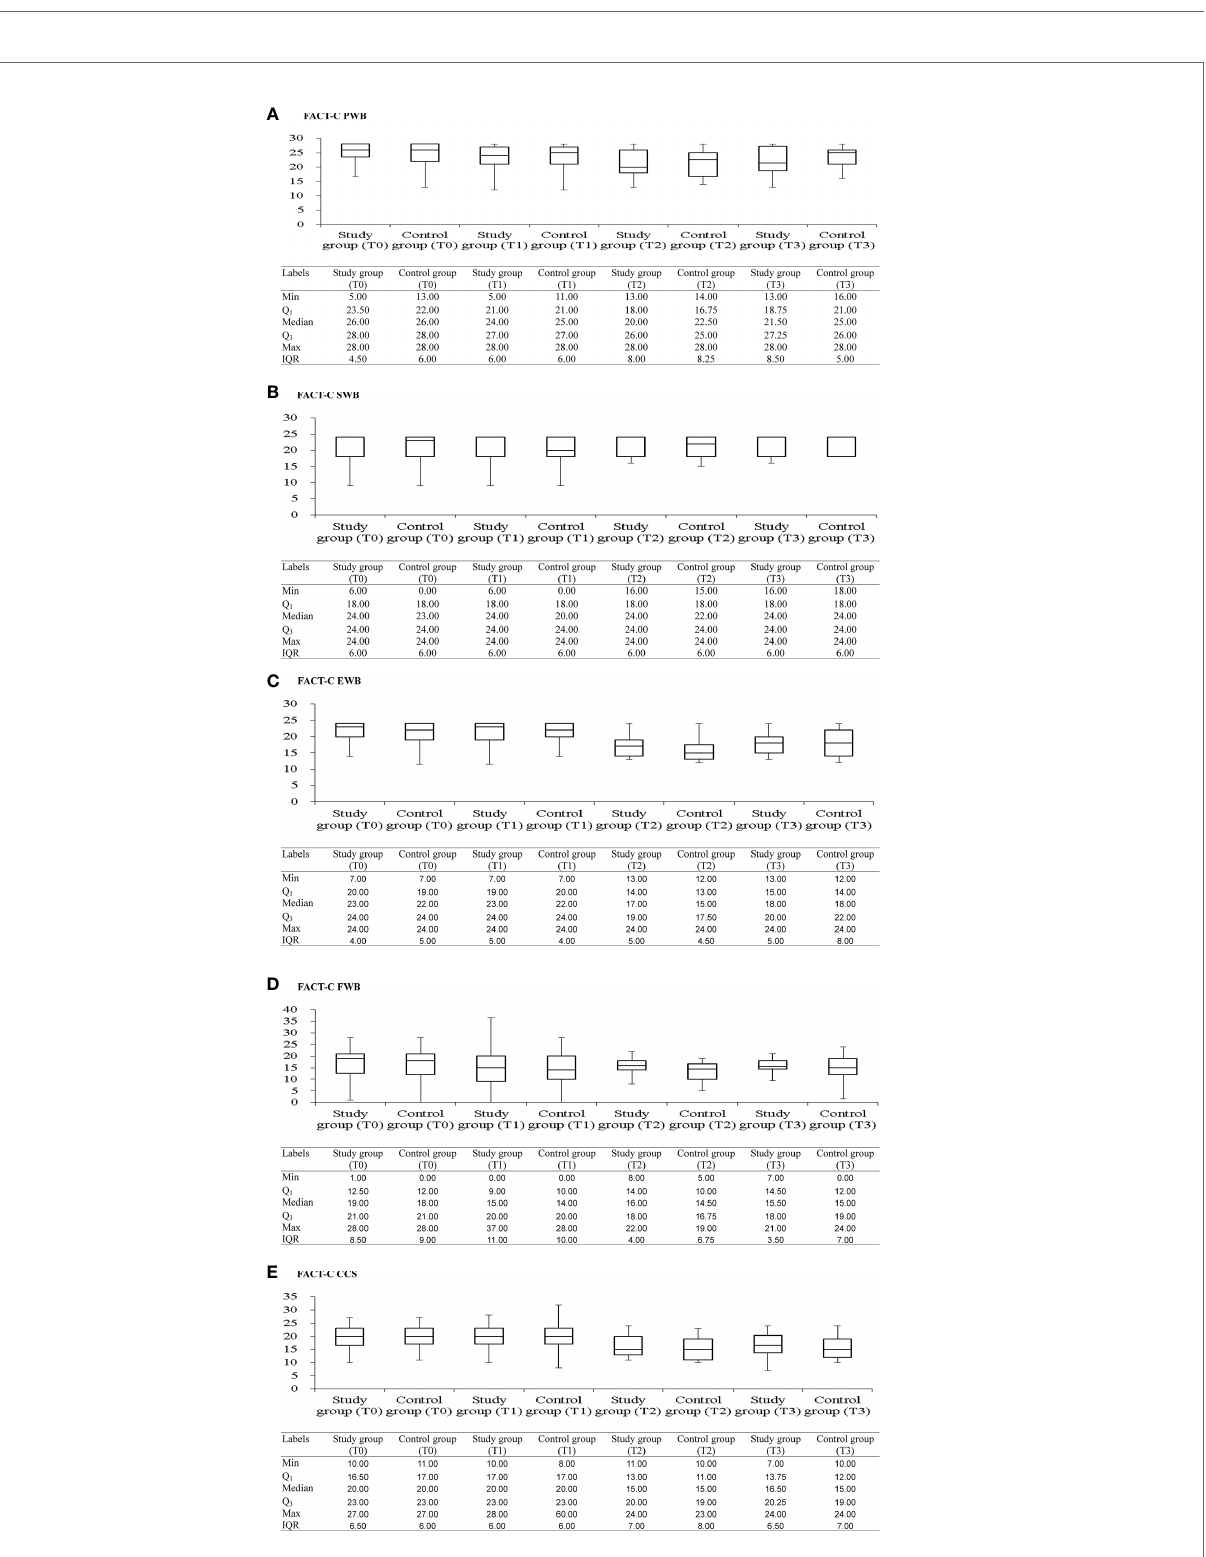
FIGURE 2 | Box and whisker plots of the FACT-C scores [ (A) FACT-C PWB; (B) FACT-C SWB; (C) FACT-C EWB; (D) FACT-C EWB; (E) FACT-C CCS] at each time-point, with study and control groups presented side by side. The box contains 50% of all values (the 25th to 75th percentile) and is divided by the horizontal bar which is the median value (50th percentile). FACT-C, functional assessment of cancer therapy-colorectal; PWB, physical wellbeing; SWB, social/family wellbeing; EWB, emotional wellbeing; FWB, functional wellbeing; CCS, colorectal cancer speci fi c wellbeing; T0, pretherapeutic; T1, posttherapeutic 6th month; T2, posttherapeutic 1st year; T3, posttherapeutic 2nd